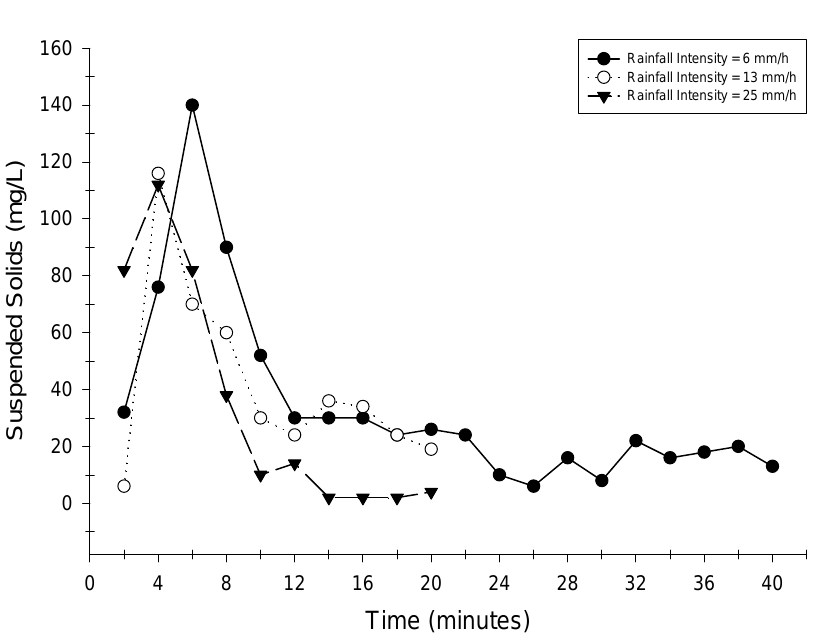
Figure 1. Pollutographs of suspended solids concentrations (mg/L) for 6.3, 12.7 and 25.4 mm/h simulated rainfall intensities. Table 1. Comparison of mean constituent concentrations (± standard deviation) at three different time intervals within a 40 min storm with an intensity of 6.3 mm precipitation per hour. N = 3 for each time interval.